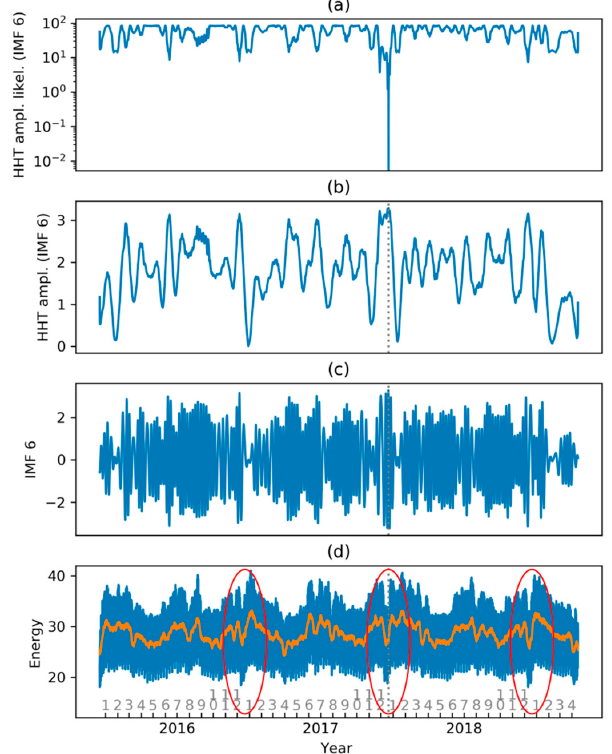
Figure 23. Abnormal behavior of IMF 6: ( a ) Instantaneous amplitude logarithmic likelihood for IMF 6; ( b ) instantaneous amplitude Hilbert Spectrum of IMF 6; ( c ) IMF 6; ( d ) electricity demand (blue) and weekly mean (orange).